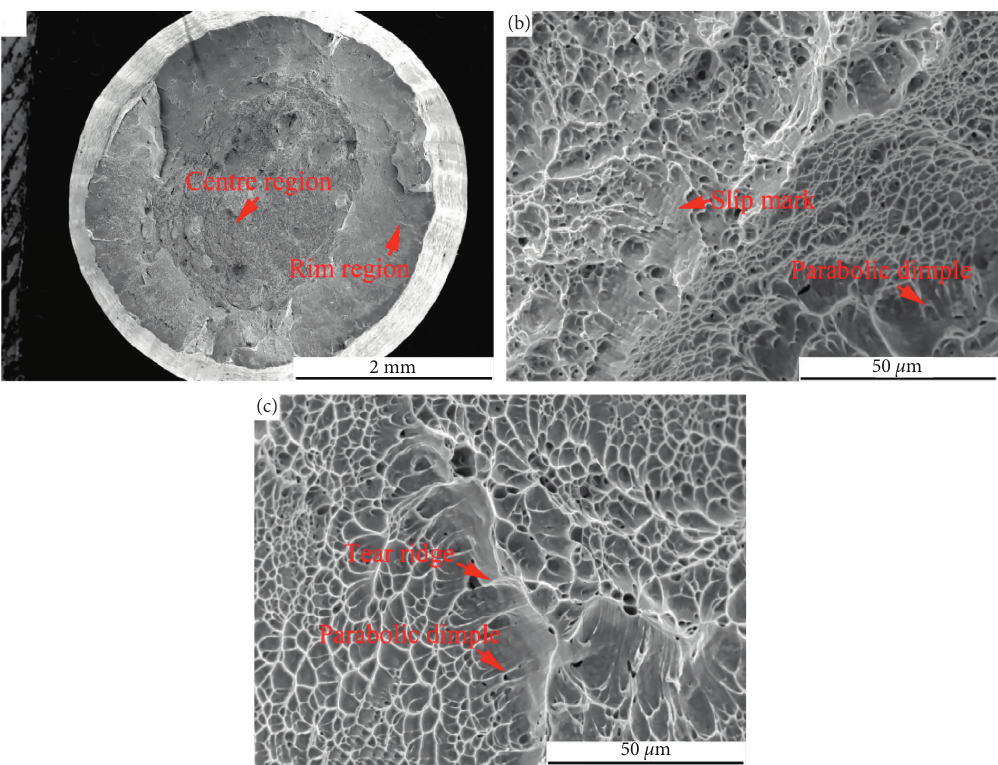
Figure 4: (a) Fracture surface of as-received materials; (b) and (c) the magnification of centre and rim regions in (a).